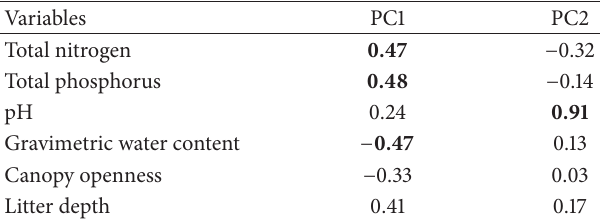
Table 2: Component loadings for first two principal components, PC1 and PC2, from principal component analysis of soil and environmental variables. PC1 and PC2 account for 40.0% and 28.3% of total variance, respectively. Variables with the highest loadings are indicated in bold.